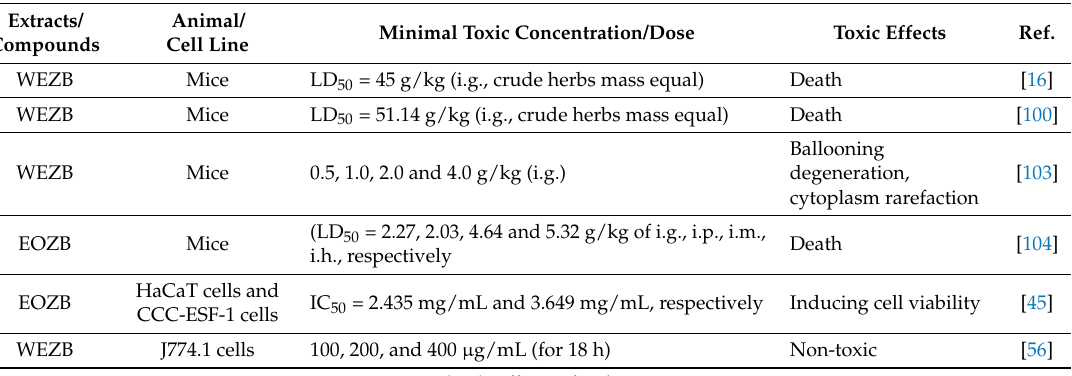
Table 8. Toxicities and side effects of Z. bungeanum